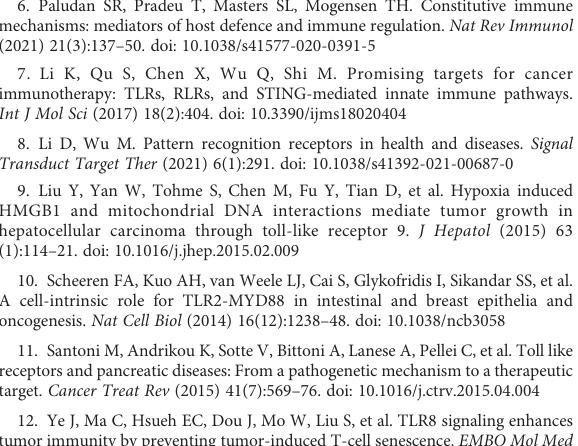
SUPPLEMENTARY FIGURE 1 The PCA plot of meta cohort before and after removing batch effects.